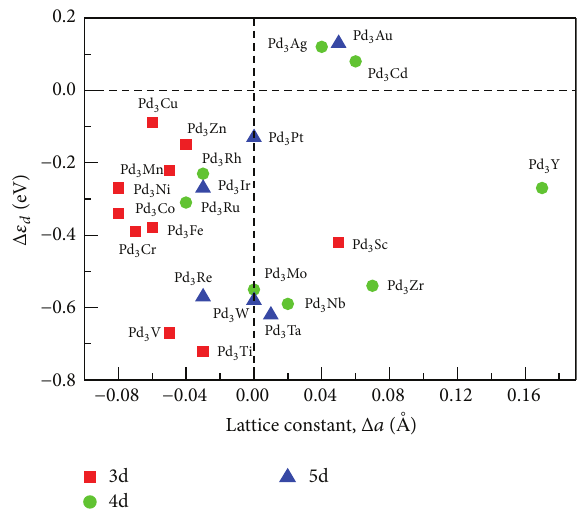
Figure 8: The DFT-calculated 𝑑 -band center ( 𝜀 𝑑 ) values for the Pd segregated surface as a function of the optimized lattice constant ( 𝑎 ) values, in which Δ𝜀 𝑑 = 𝜀 𝑑 ( Pd